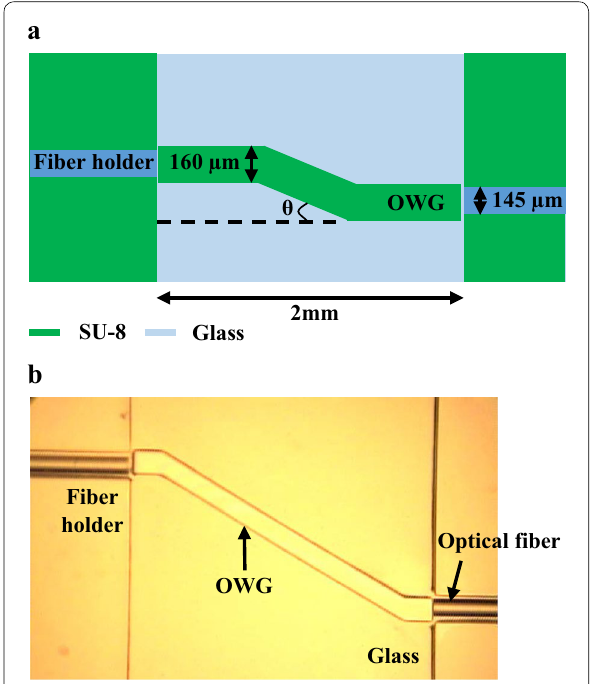
Fig. 1 Schematic diagram of the OWG and the microscope image. a Design values and b fabricated SU‑8 OWG are